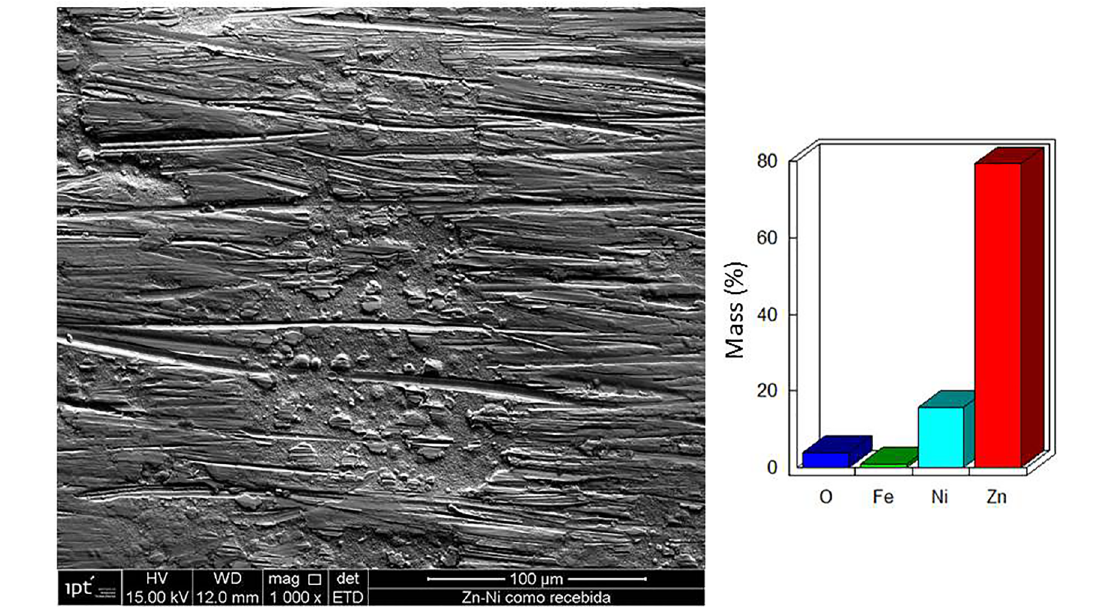
Figure 1. Surface morphology of 22MnB5 steel electroplated with Zn-Ni and its respective